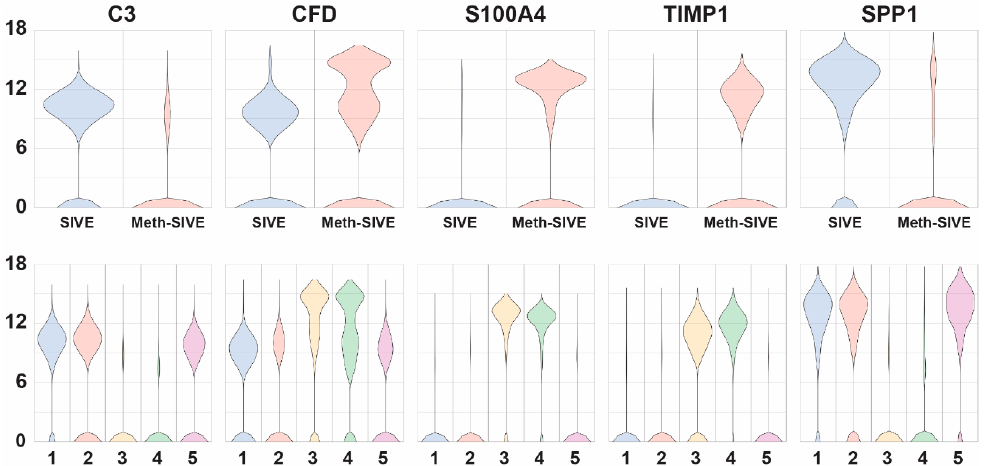
Figure 6. Violin plots showing relative expression of genes that are differentially expressed between SIVE and Meth-SIVE in the two different conditions (upper) and the five different clusters (lower). The genes shown are bolded in the